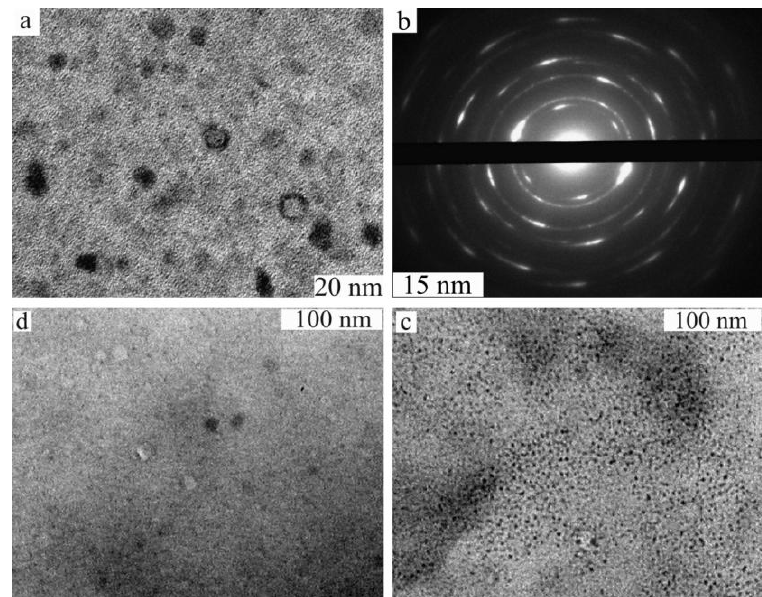
Figure 8. TEM images of the catalyst Pd-PVI-PVC (1:5): (a) after the reaction with PhI and n- butyl acrylate; (b) a diffraction pattern; (c) after heating in DMF for 1 h; (d) after the reaction of cyanation of p